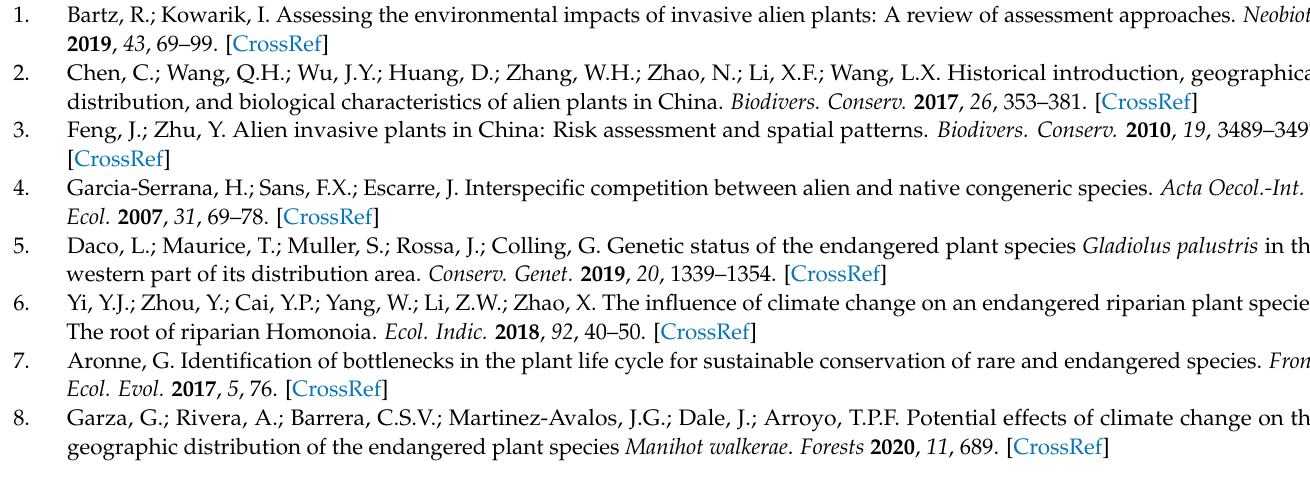
Table S3: Categories of Chinese rare species (1898) based on International Union for Conservation of Nature (IUCN) Red List, Table S4: Five dispersal strategies and 21 dispersal modes of diaspores based on previous literature (Adapted from Zhou Q, 2020), Table S5: Numerical scale for pairwise comparison, Table S6: Random coincidence index value (RI), Table S7: Assessment indices system of adaptive capacity of alien and rare plants in stressful and disturbed environment and weight vector of primary and secondary indicators as well as score of the secondary indicators, Figure S1: Steps of analytic hierarchy process (AHP) method for evaluation of adaptive capacity of alien and rare plants to environment, Figure S2: Assessment indices system of adaptive capacity to